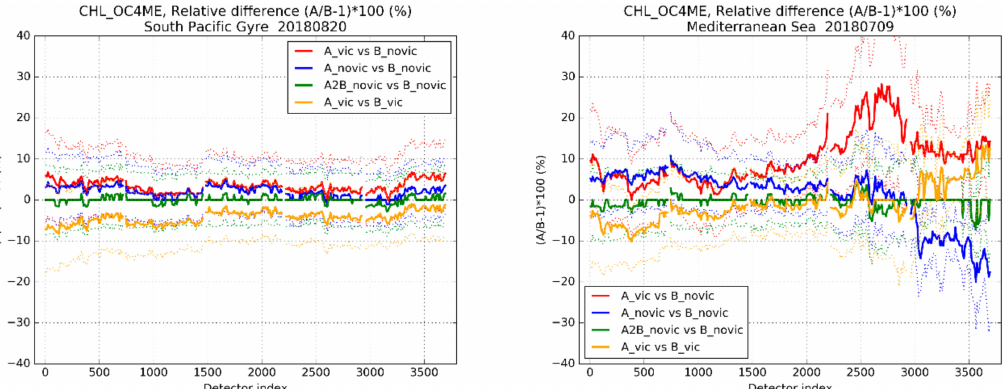
Figure 13. Relative di ff erences of OLCI-A and OLCI-B water-leaving reflectance (Oa03, 443 nm, left : Oa06, 560 nm, right ) for South Pacific Gyre ( top ) and Mediterranean Sea ( bottom ). OLCI-A processed with three calibration setups when compared to OLCI-B without SVC: no SVC and no alignment (blue), SVC (red), alignment to OLCI-B (green). In yellow, OLCI-A with SVC compared to OLCI-B with preliminary SVC. Median and dispersion per OLCI detector. Eastern part of the FOV a ff ected by sun-glint in the MED scenario.